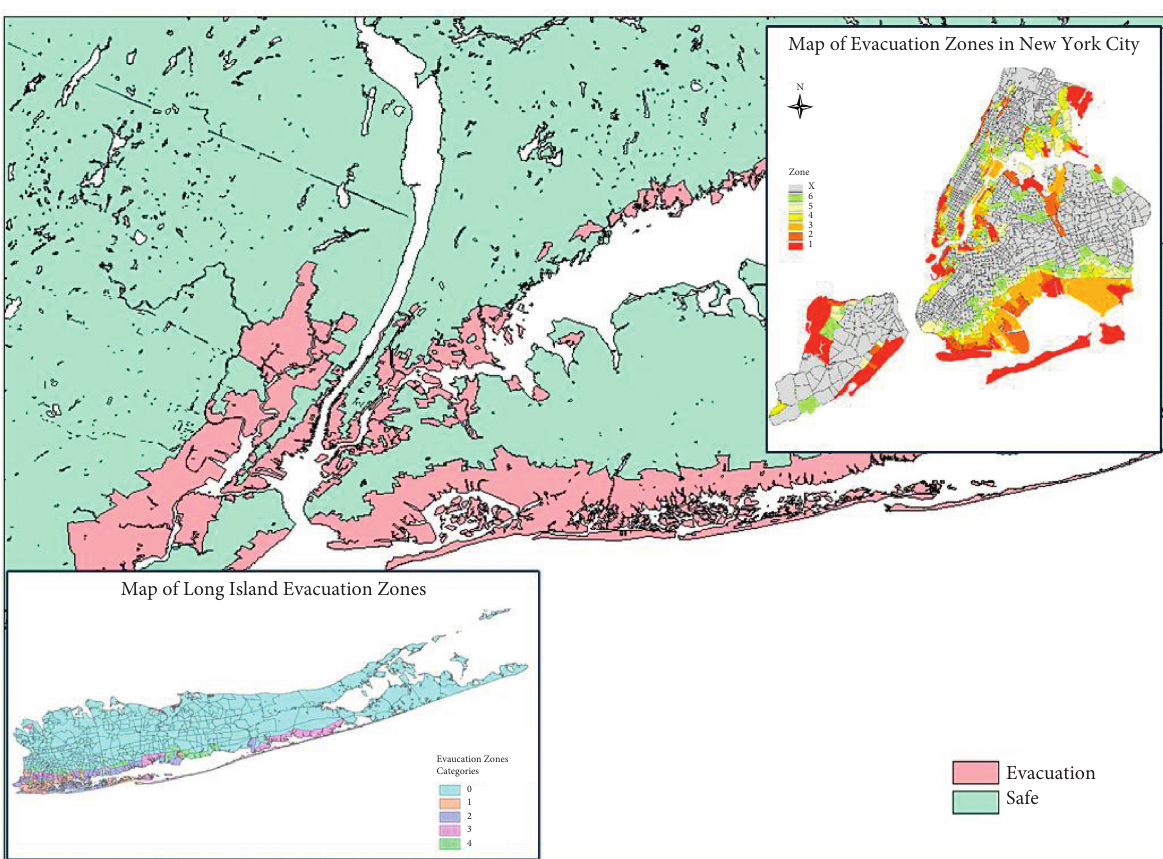
Figure 2: Evacuation and safe zones in this